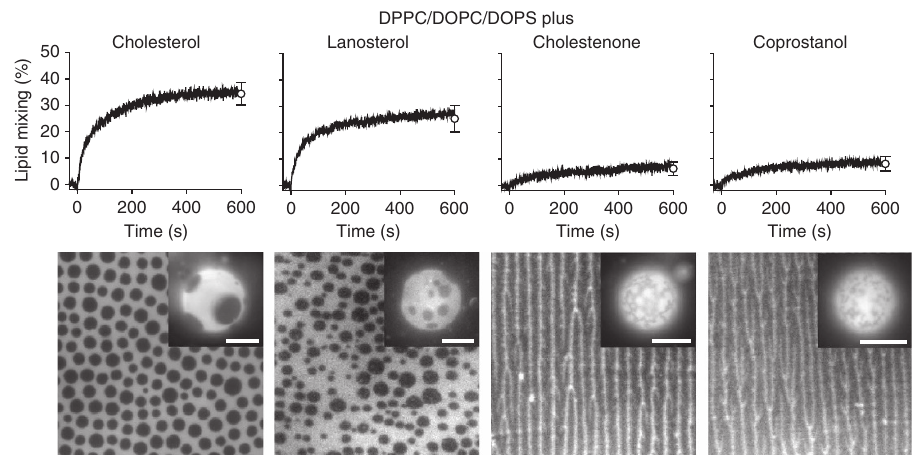
Figure 4 | Effect of different sterols on Lo domain formation and membrane fusion. Lipid mixing with 1 m M HIV-FP added to 50 m M LUVs composed of DPPC/DOPC/DOPS/sterol (2:1:1:1; top row). Sterols from left to right are cholesterol, lanosterol, cholestenone and coprostanol as indicated. Fluorescence micrographs of supported lipid monolayers and GUVs (insets) with corresponding lipid compositions and labelled with 0.1mol% Rh-PE (bottom row). The scale of all lipid monolayers is 60 (cid:2) 60 m m 2 and scale bars in insets are 10 m m. Error bars are s.d. of three